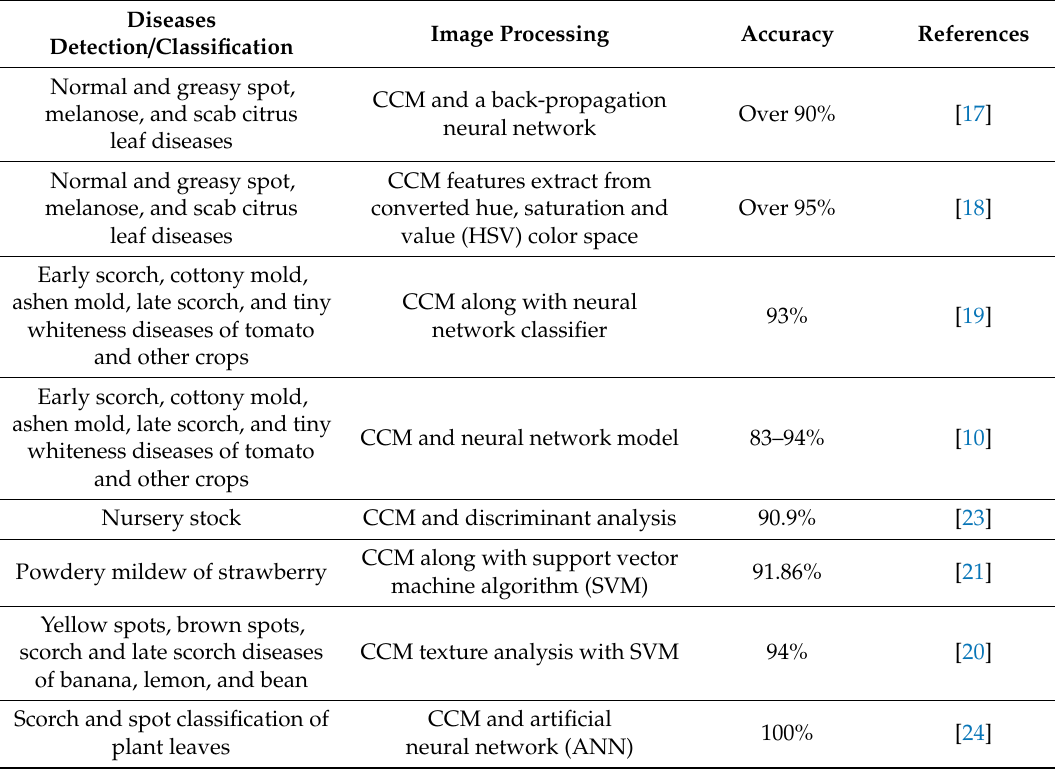
Table 1. Summary of disease detection accuracies using color co-occurrence matrix (CCM)-based textural analysis in di ff erent cropping systems.